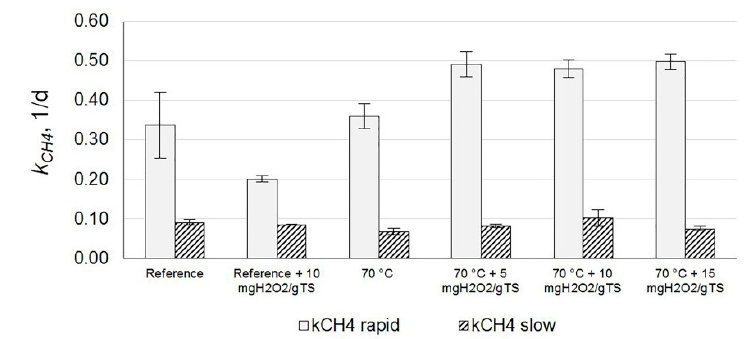
Figure 3. Methane production rates following pre-treatments during experiment #2, at an exposure time of 30 min. n = 3 except for reference + 10 mg H 2 O 2 /gTS, which had n = 2.